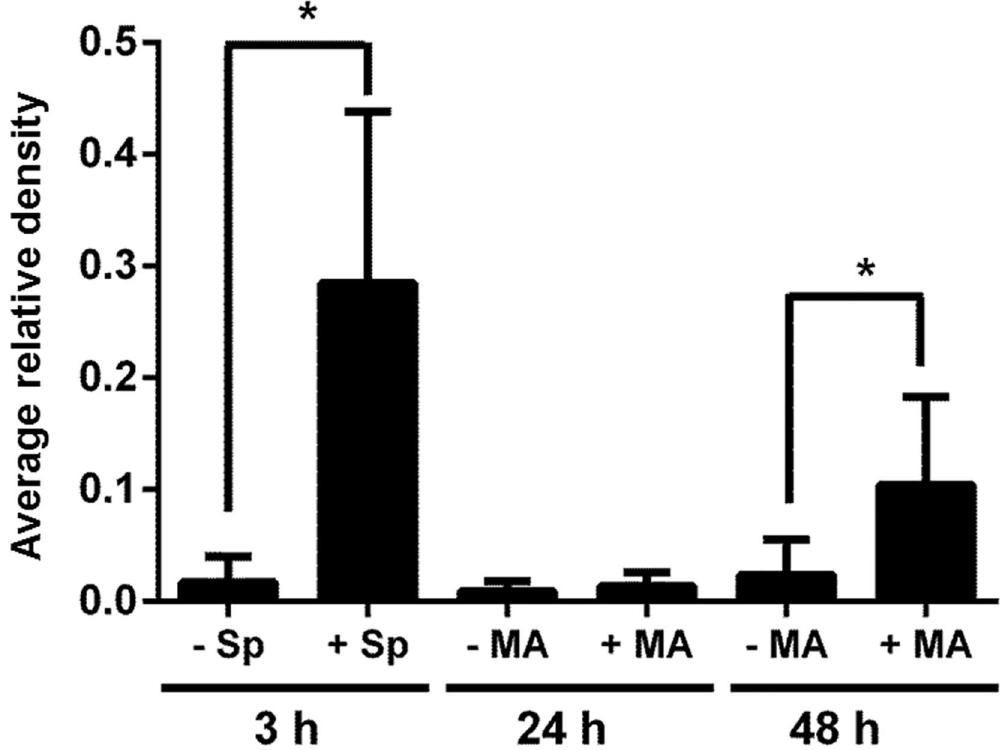
Fig 4. Caspase-3 cleavage in M . agalactiae -infected HeLa cells. The graph represents the averagerelative density of cleaved caspase-3 from the immunoblots of M . agalactiae -infected (+ MA) and uninfected (- MA) HeLa cells at 24 and 48 h. As a positive control, HeLa cells were treated with 1 μ M staurosporine (Sp) for 3 h. Experiments were performed at least three times, and averagerelative density values ± standard deviationare represented here. ‘ * ’ indicates p < 0.05.